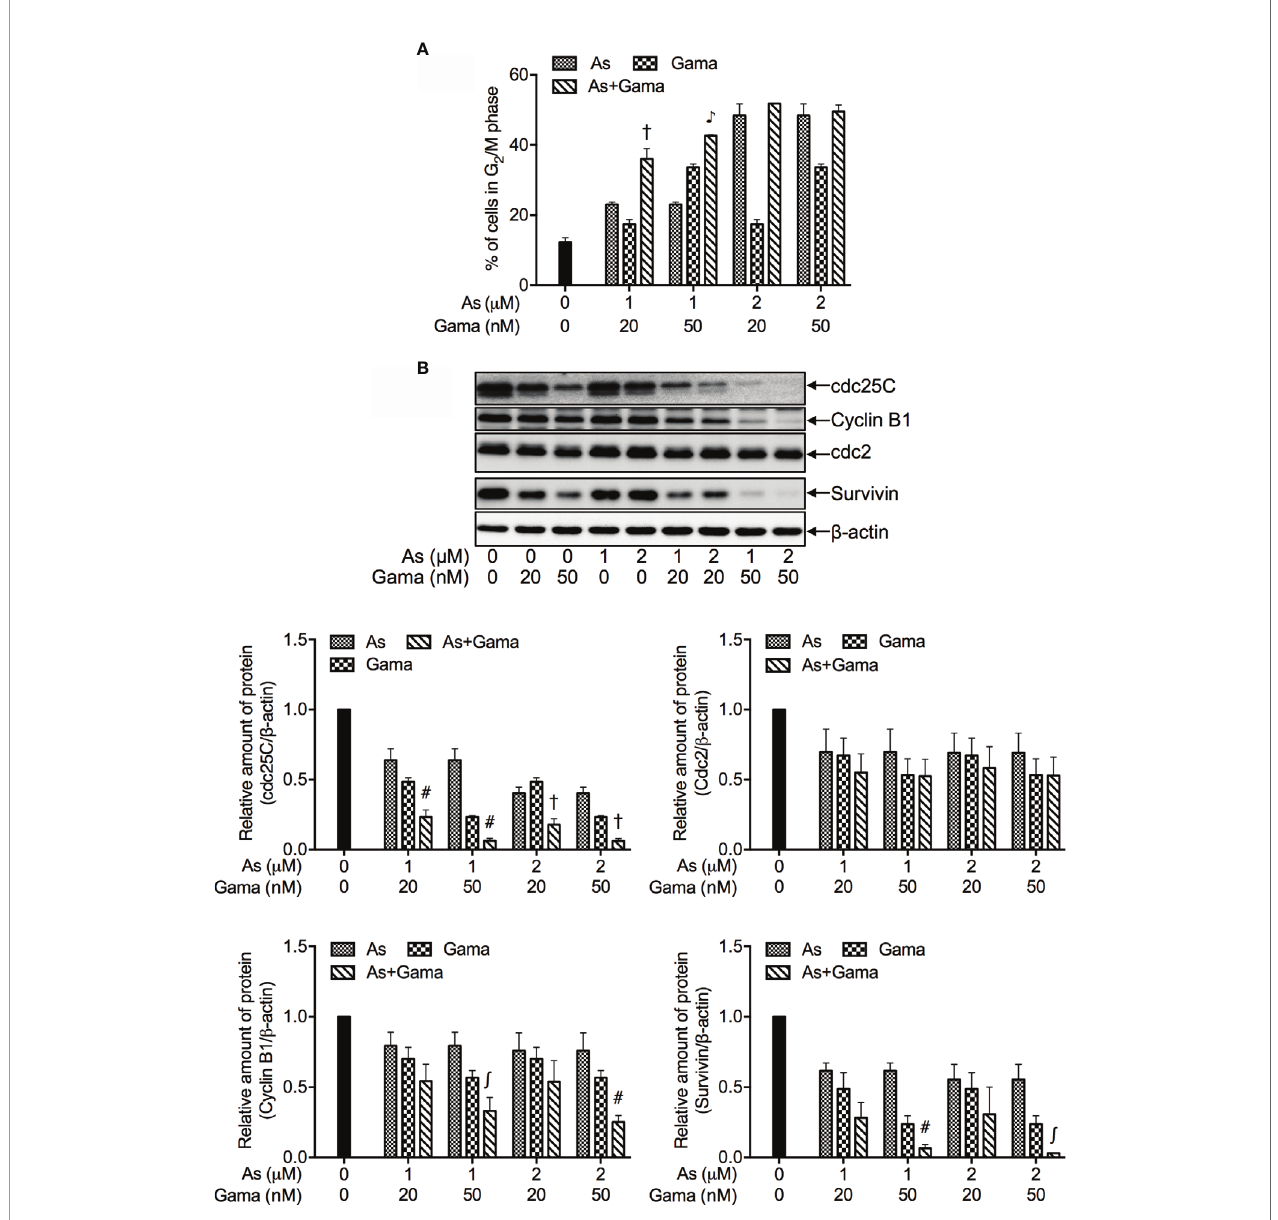
FIGURE 4 | Effects of relatively low concentrations of As III in combination with gamabufotalin on G 2 /M arrest and the expression level of cell cycle related-proteins in U-87 cells. Following treatment for 48 h with As III (1 and 2 µM) and gamabufotalin (20 and 50 nM), alone or in combination, cell cycle pro fi ling was performed by FACSCanto fl ow cytometer as described under Materials and Methods . A total of 10,000 events were acquired, and FACSDiva ™ software and ModFit LT ™ v3.0 were used to calculate the number of cells at G 2 /M phase fraction (A) . Results are shown as the means ± SD (n ≥ 3). After the same treatment, the expression pro fi les of cell cycle-associated proteins were analyzed using western blotting. A representation image of the expression pro fi le of each protein is shown from three independent experiments (B) . The expression levels were expressed as the ratios between each targeted protein and b -actin protein expression levels, and were compared with those of control group. ∫ p < 0.05; # p < 0.01; † p < 0.001; ♪ p < 0.0001 vs. each alone. As, As III ; Gama,